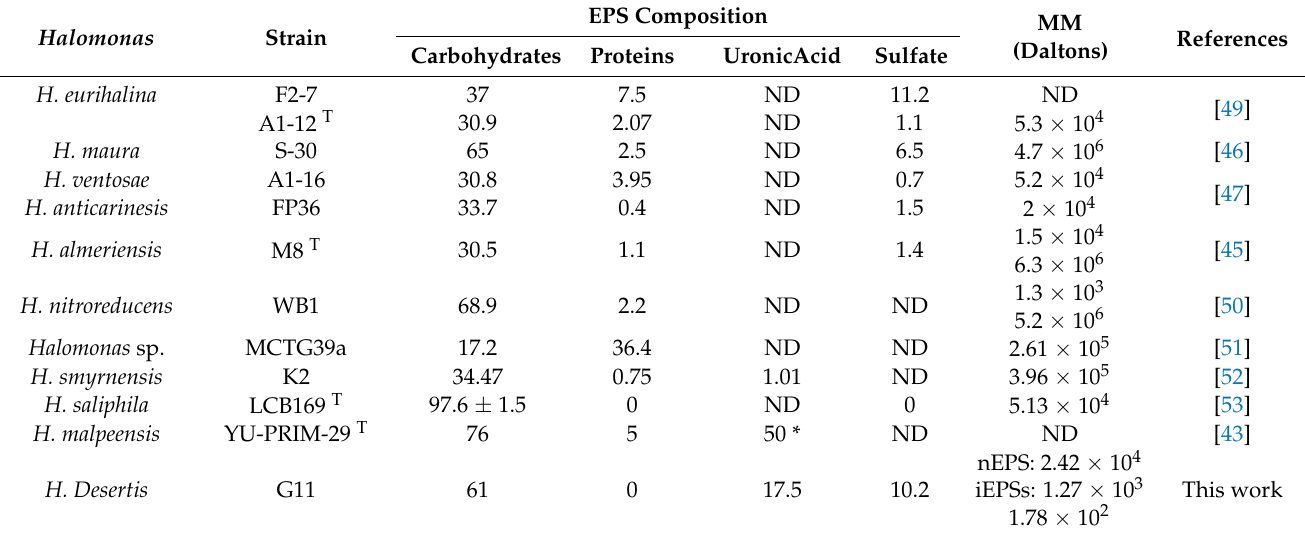
Table 2. Characteristics of EPSs produced by Halomonas strains (* among the total carbohydrates 50% were uronic acid, T: It's part of the strain code).